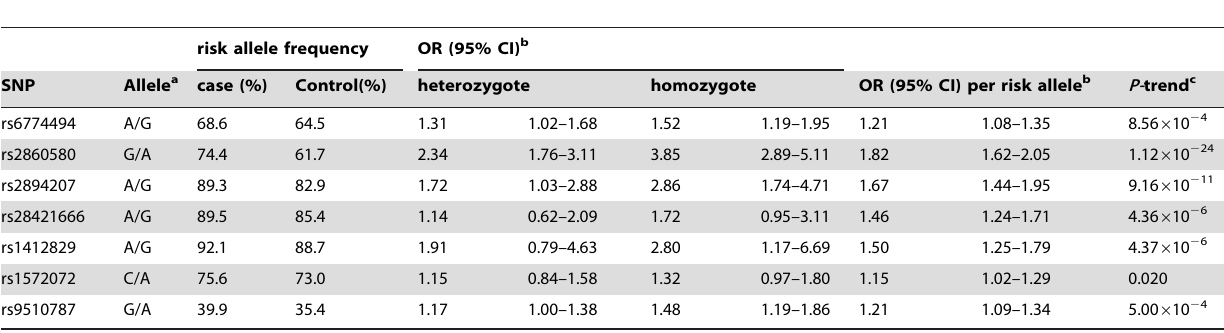
Table 1. Association between risk of nasopharyngeal carcinoma and seven single-nucleotide polymorphisms.